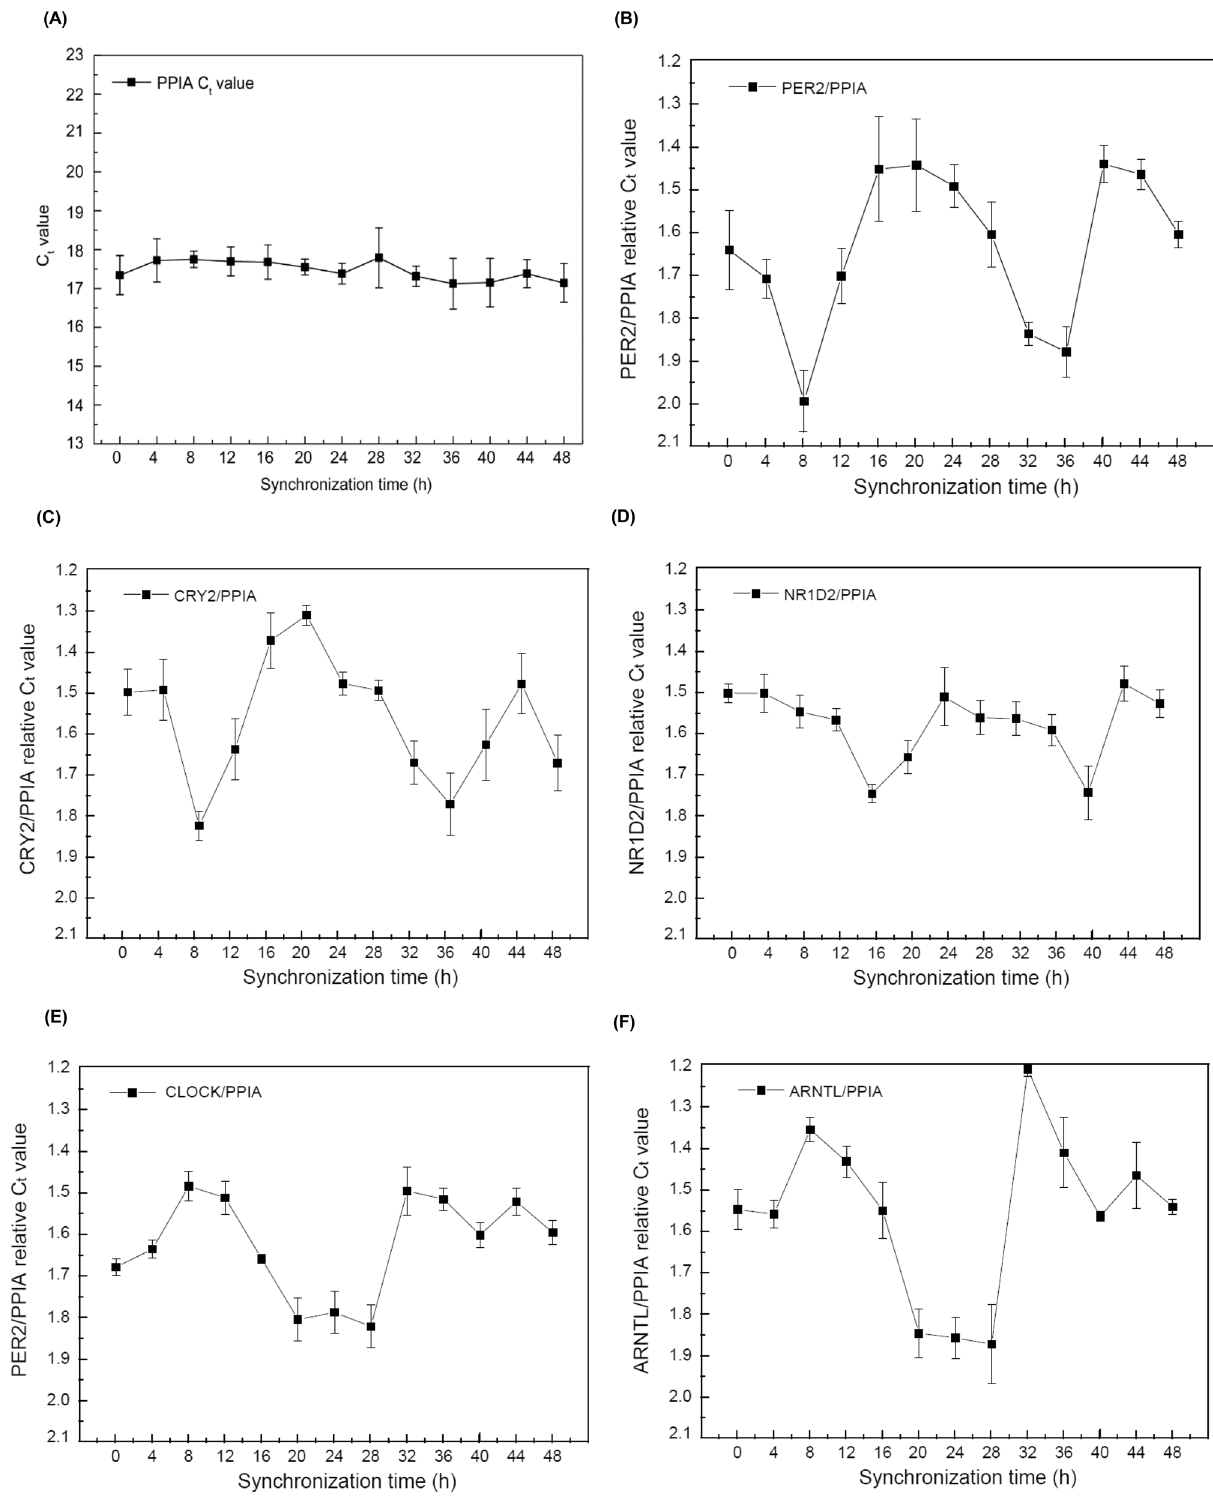
Figure 4. Synchronization test for HeLa cells with forskolin induced circadian gene expression of PER 2 CRY 2 CLOCK, ARNTL, NR 1 D 2 and PPIA mRNAs. ( A ) Expression level of internal control gene (PPIA) for 48 h with a time interval of 4 h (n = 5) was analysed. ( B – F ) Relative C t values of circadian rhythm genes with respect to the internal control (n = 5). PER2, CRY2, and CLOCK, ARNTL showed an inverse fluctuation during the whole 48 h. Cyclic fluctuation occurred at 8 h in NR1D2 when compared to that of PER2,